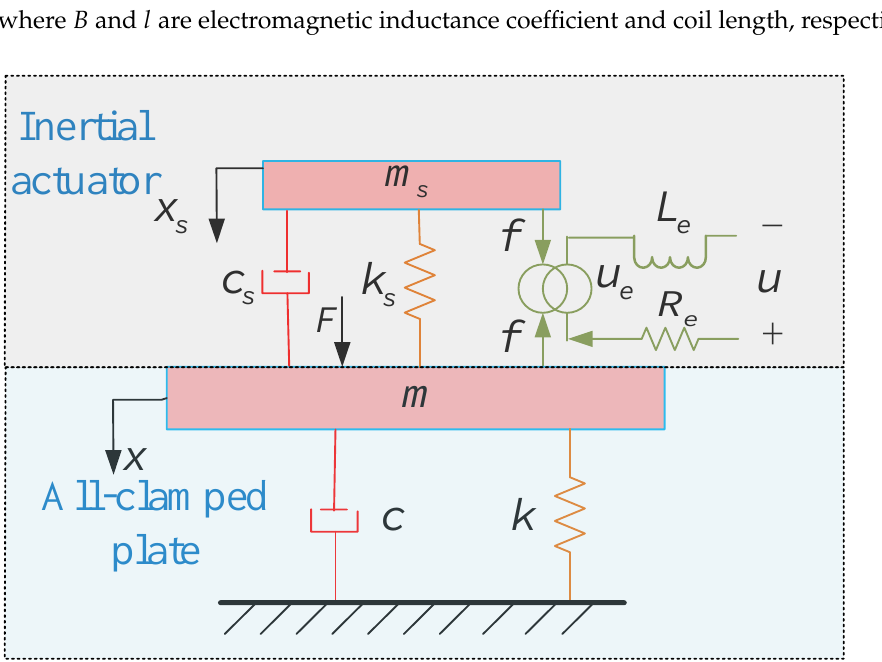
Figure 1. Structure drawing of all-clamped plate with inertial actuator.